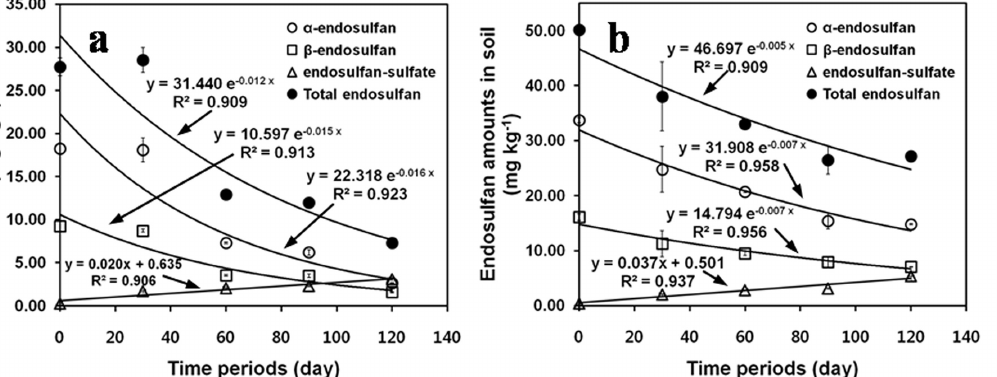
Fig 3. Residual patterns of isomers and sulfate-metabolite of ED in soils in (a) 20 mg kg -1 and (b) 40 mg kg -1 -treated plots as observed in an outdoor greenhouse experiment.